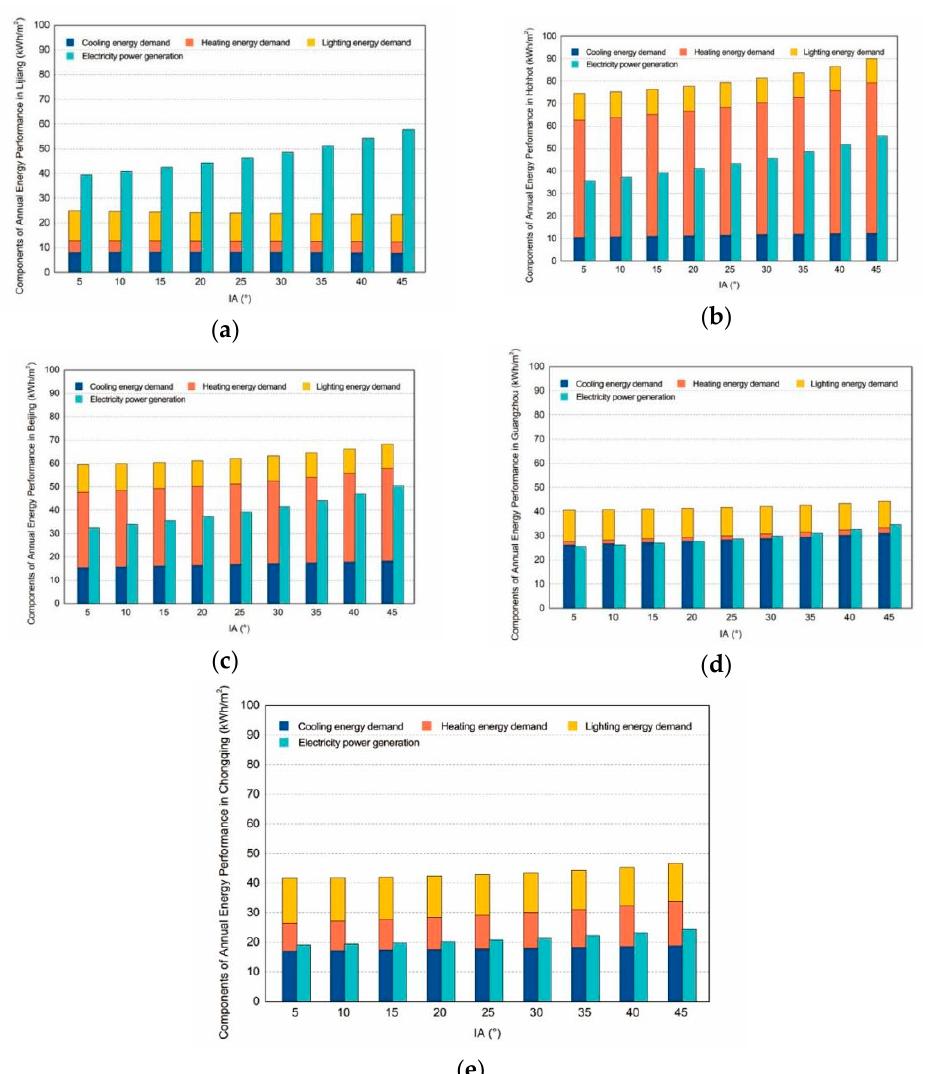
Figure 6. Energy performance of STPV skylights integrated into sloped roofs. ( a ) Case 1: Lijiang; ( b ) Case 2: Hohhot; ( c ) Case 3: Beijing; ( d ) Case 4: Guangzhou; ( e ) Case 5: Chongqing.